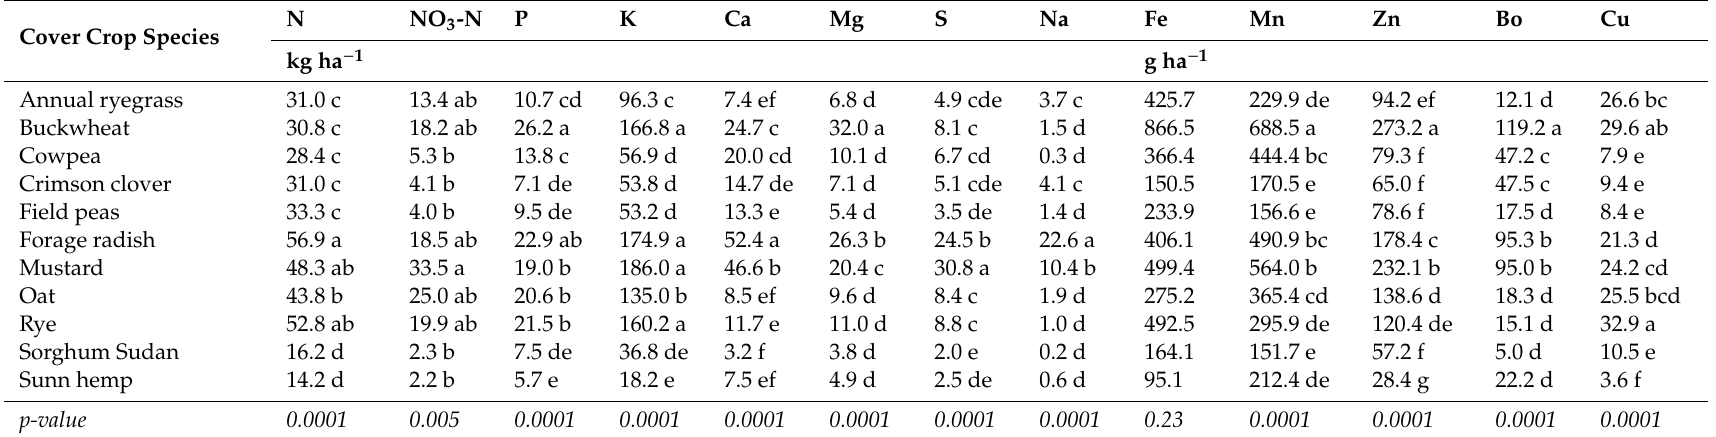
Table 4. Macro and micronutrient uptake and potential contribution to soil fertility of above-ground tissues of selected cover crop species at 32 days after sowing 1 . Cover Crop Species Annual ryegrass